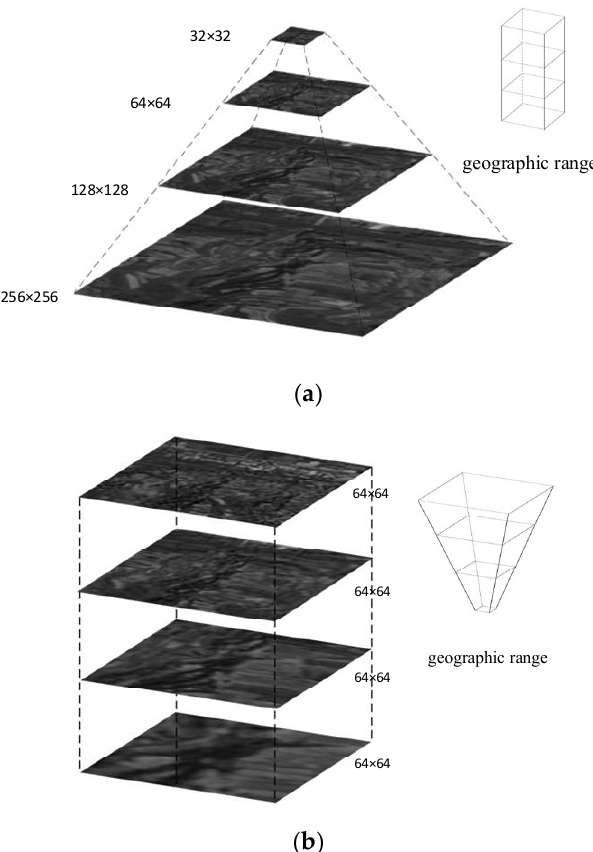
Figure 3. Traditional image pyramid and geographic pyramid. ( a ) Traditional pyramid; ( b ) geo- graphic pyramid.